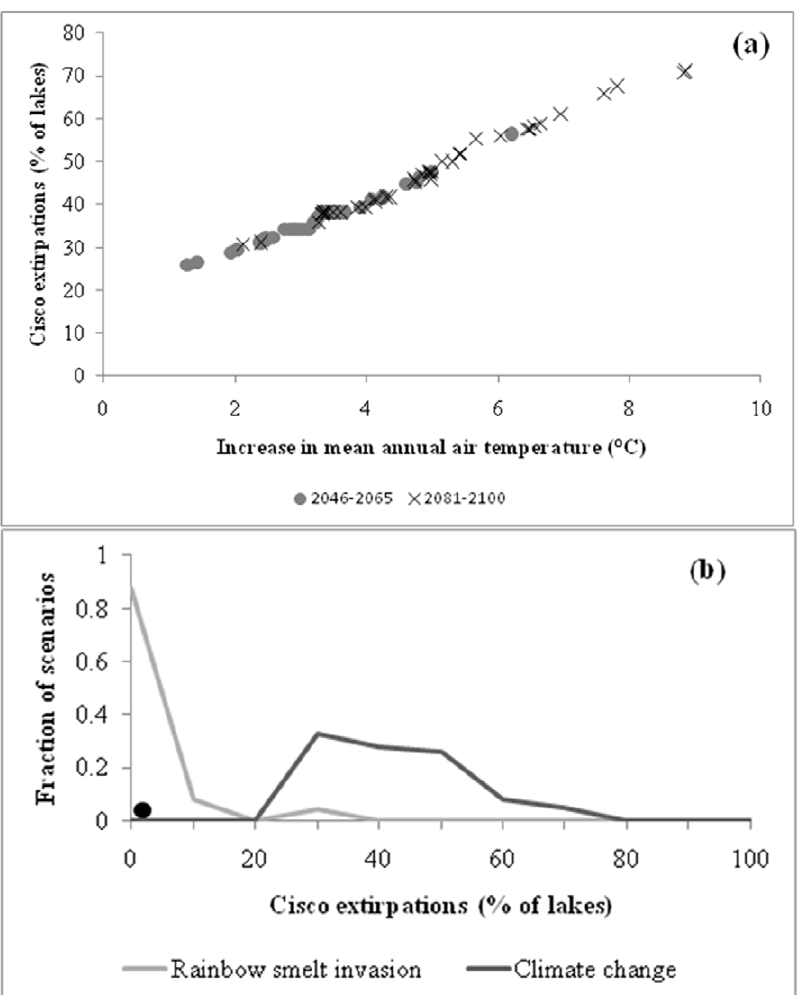
Figure 2. Impacts of climate change on cisco extirpations. a) Percent cisco extirpation with increases in average mean annual air temperature ( u C) resulting from climate change across Wisconsin lakes. Percent cisco extirpation was predicted by incorporating estimates of changes in mean annual air temperature ( u C) derived from the 78 climate change scenarios into the cisco occurrence model (Equation 6). Predicted cisco extirpations for mid-century (2046–2065) are depicted by grey circles and predicted cisco extirpations for late century are depicted by black crosses. b) Fraction of scenarios predicting cisco extirpations (a percentage of current cisco populations) in Wisconsin resulting from climate change versus the invasion of rainbow smelt. Cisco extirpations from climate change incorporated uncertainty from 78 climate change scenarios. Cisco extirpations from rainbow smelt invasion incorporated uncertainty on rainbow smelt invasion rates and the direct extirpation of cisco as a result of rainbow smelt invasion. The solid circle represents the current best estimate of cisco extirpations under rainbow smelt invasion (assuming a spread rate of 0.5 and an impact rate of 0.2).